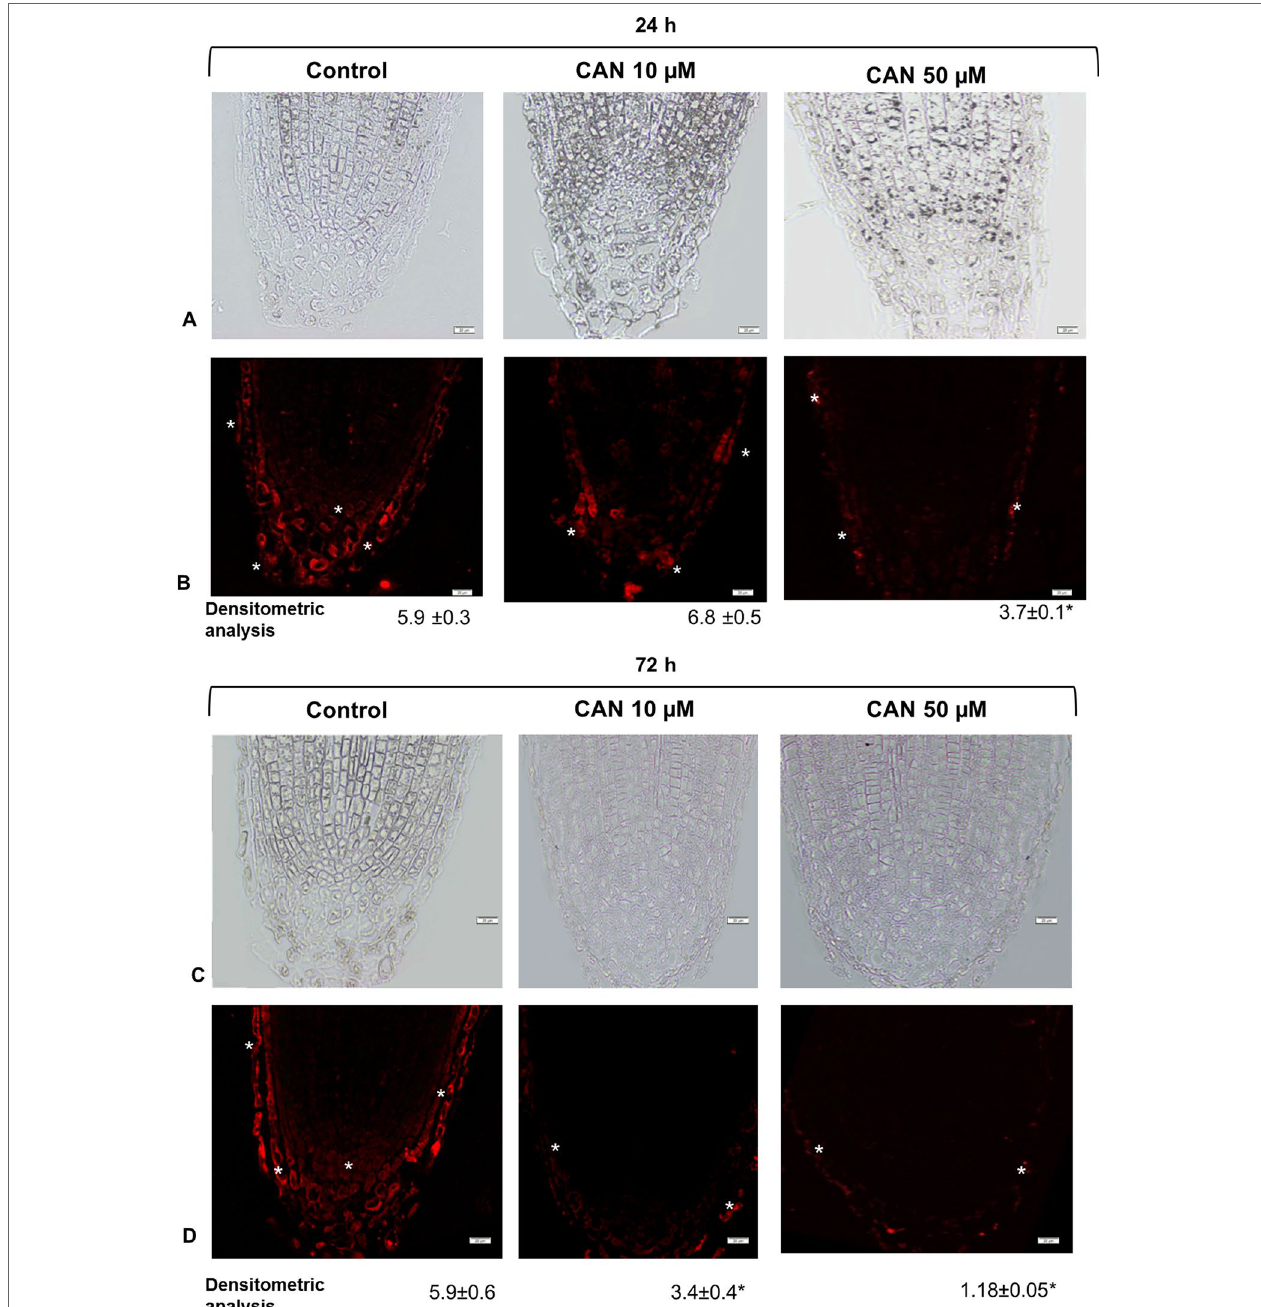
FIGURE 5 | GSNO-related red fluorescence signal (*) in root apex of tomato seedlings growing in CAN (10 or 50 µM) for 24 h ( panels A and B ) and 72 h ( panels C and D ) . Panels (A) and (C) present the bright field, panel (B) and (D) corresponding to them fluorescence images. Scale bars 20 µm. Experiments were performed three times, and representative data are